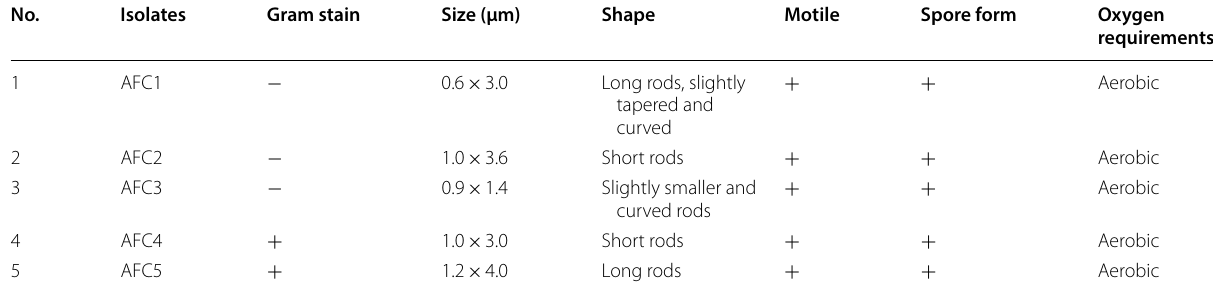
Table 2 Cell morphology of the isolated bacteria from termite gut contents No.